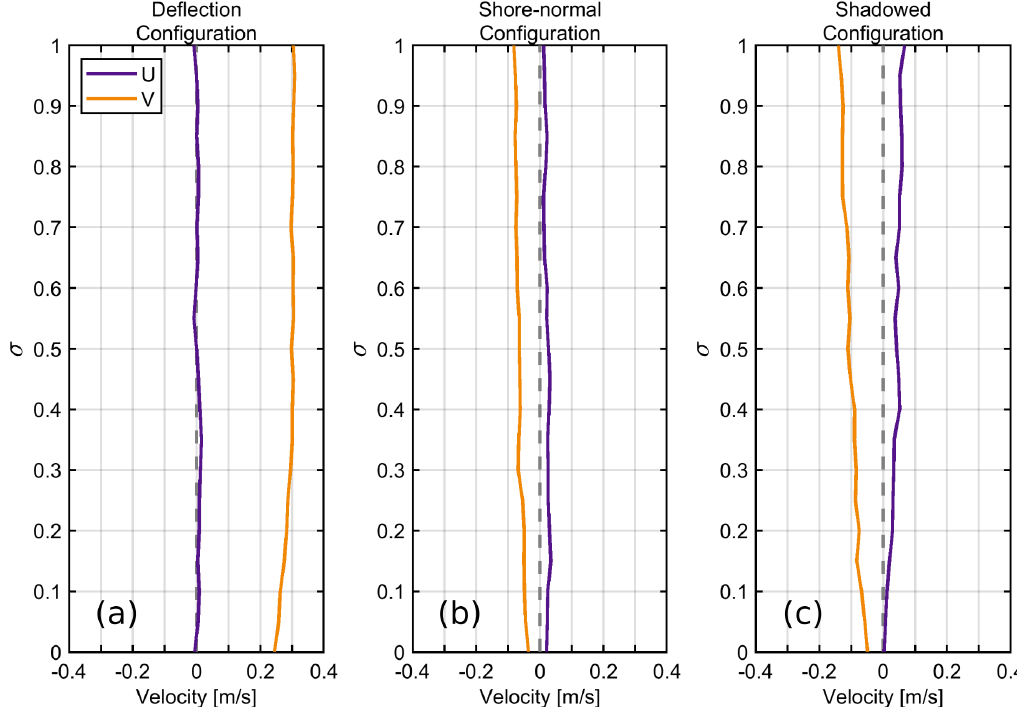
Figure 10. ADCP 2-h burst-averaged σ -velocity profiles under different offshore incident wave obliquity at low tide. ( a ) Deflection configuration (8 October 2018-08–10:00:00 GMT), ( b ) shore-normal configuration (11 October 2018-11–13:00:00 GMT) and ( c ) shadowed configuration (15 October 2018-12–14:00:00 GMT). Longshore ( U > 0; current directed away from the headland) and cross-shore ( V > 0; offshore-directed current) velocity components are shown in purple and orange colors,